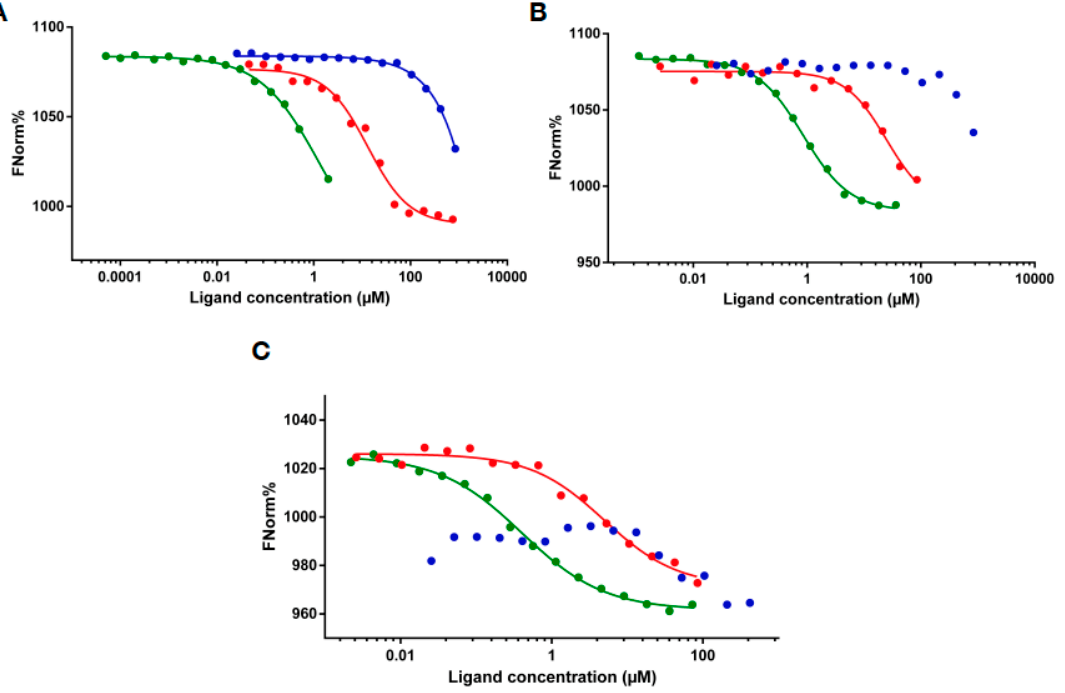
Figure 2. RNA binding detected by microscale thermophoresis. MST binding curves of MLL4 3500–3630 (green), MLL4 4210–4280 (red) and thymosin beta 4 (blue) to different RNAs: HOTAIR 440 ( A ), MEG3 ( B ) and 50 nt RNA ( C ).